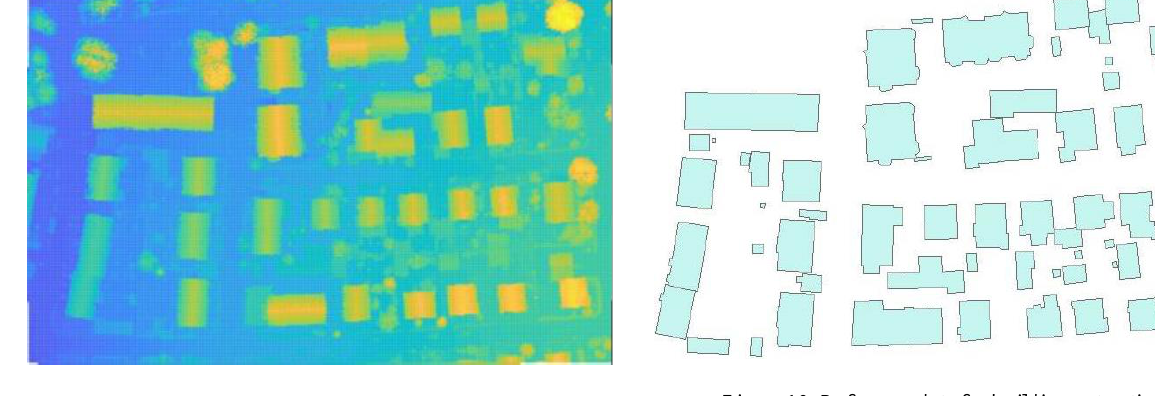
Figure 7. The ALS data of the Vaihingen test site